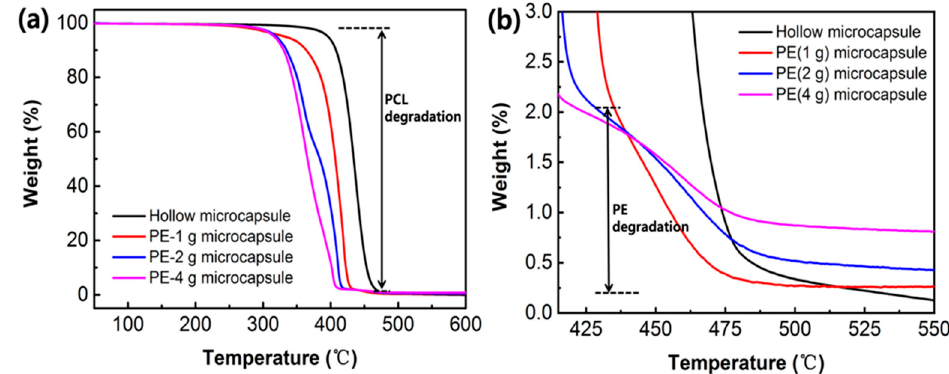
Figure 4. TGA curve of ( a ) the microcapsules with different amounts of core material and ( b ) the heating temperature from 412.5 to 550 °C of these microcapsules at 10 °C/min under an N 2